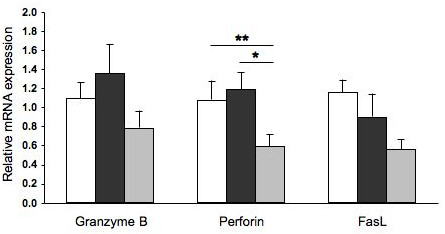
Perforin, granzyme B, and FasL mRNA expression by isolated peripheral CD8+/CD16- cells. For each subject, total RNA was extracted from magnetically isolated CD8+/CD16- cells. mRNA expression of granzyme B, perforin, and FasL was assessed by real-time PCR, using 18S rRNA as housekeeping gene and compared using 2-ΔΔCt method. Columns represent mean ± SEM. *p = 0.02; **p = 0.05. Normal non-smokers (white), normal smokers (black), and emphysematous smokers (grey).